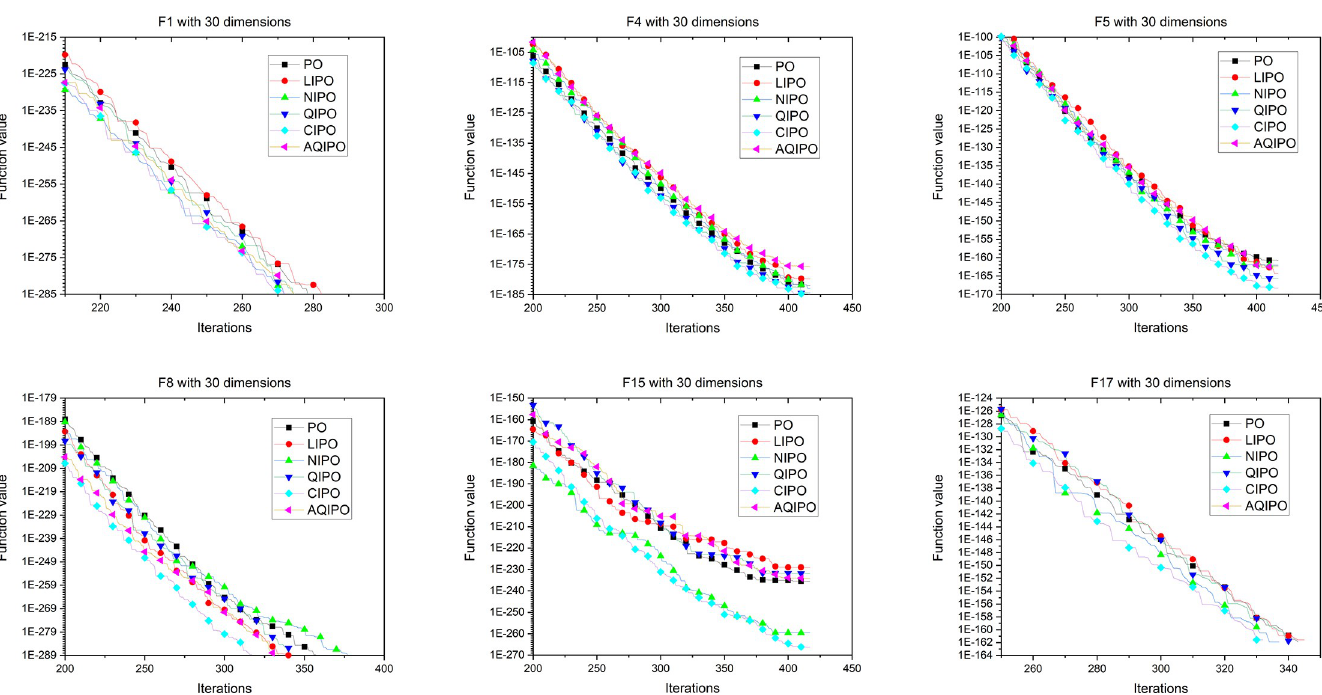
Fig 9. Convergence curve on 6 representative benchmark functions with 30 dimensions.